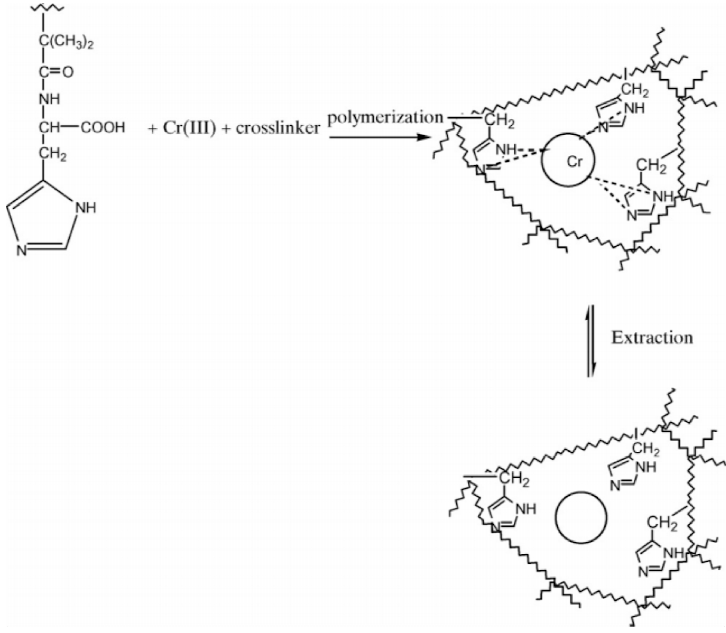
Figure 6. Preparation of chromium (III)-imprinted polymeric adsorbent. Republished with permission of Elsevier, from [39]; permission conveyed through Copyright Clearance Center,